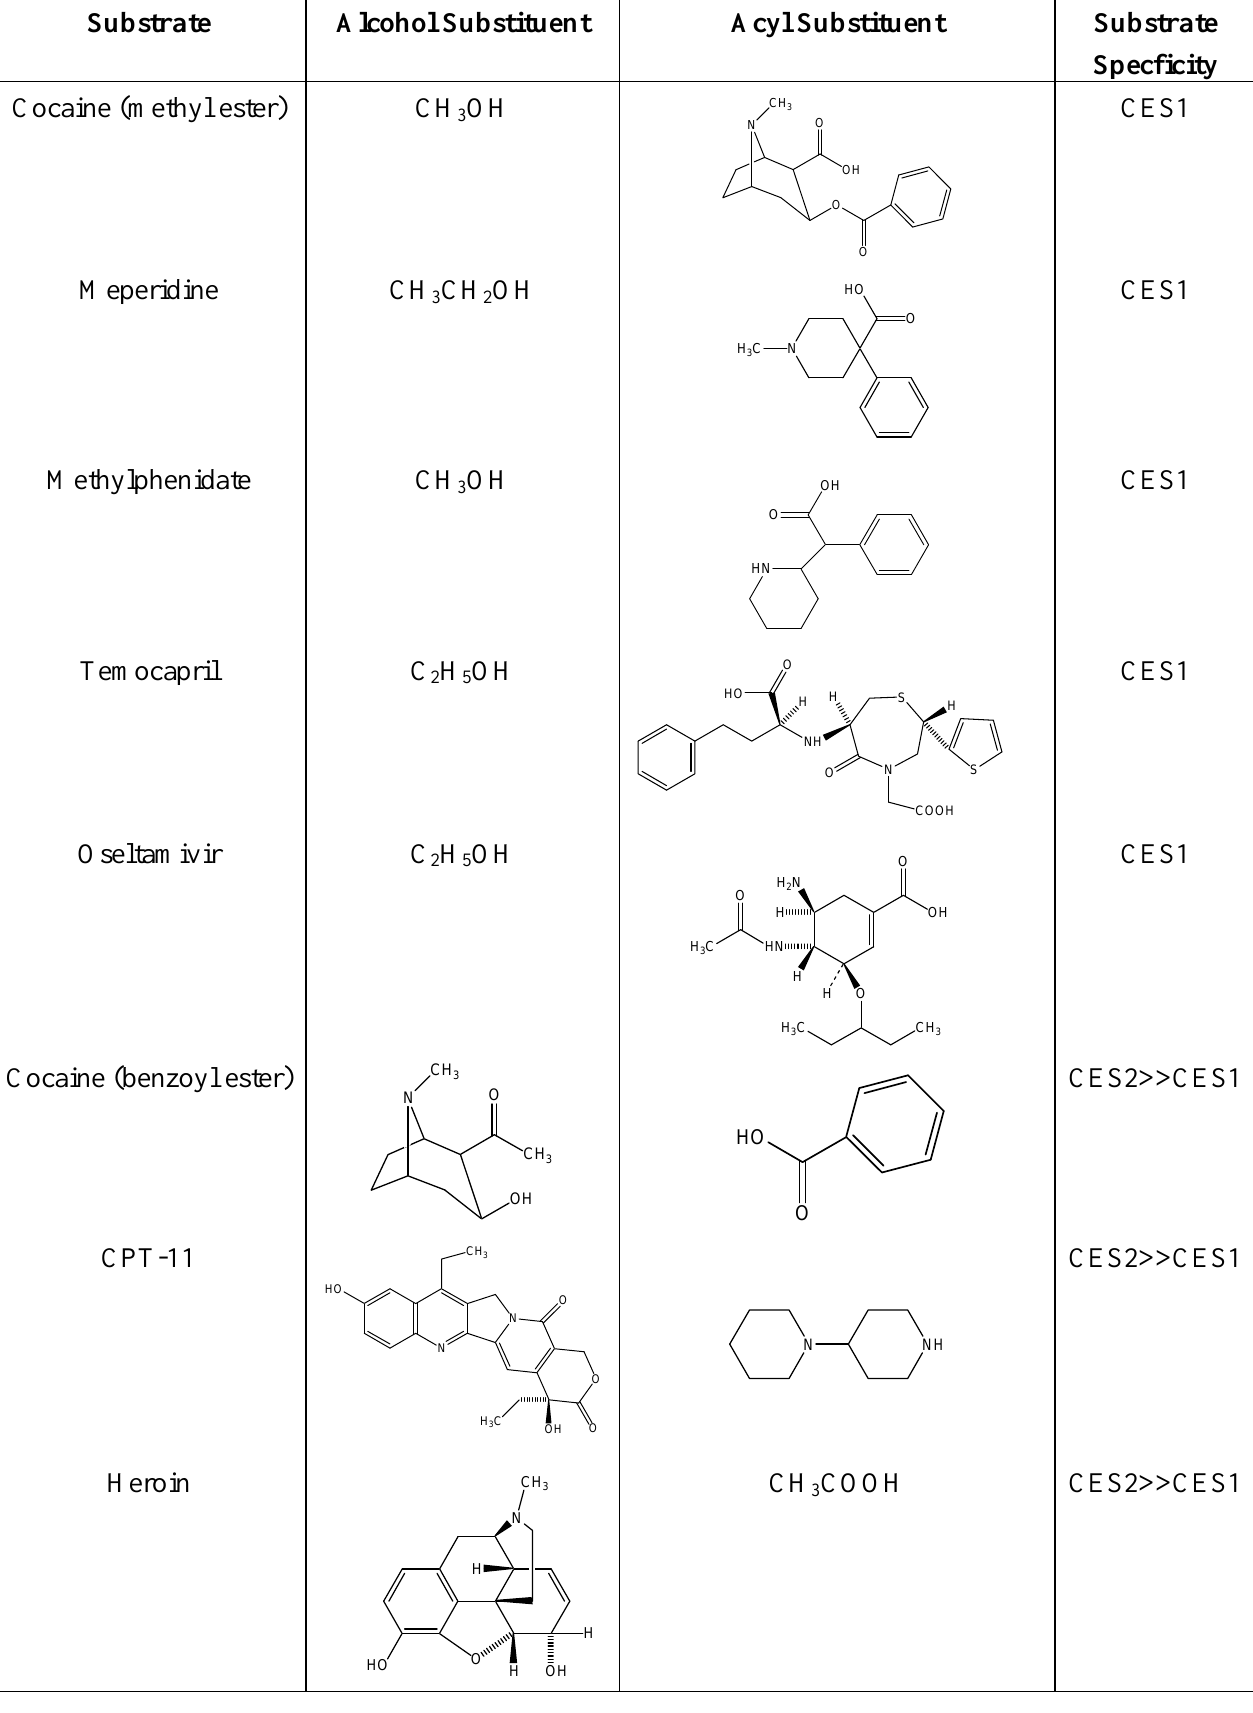
Table 1. Structure-activity relationship of substrates with CES1 and CES2